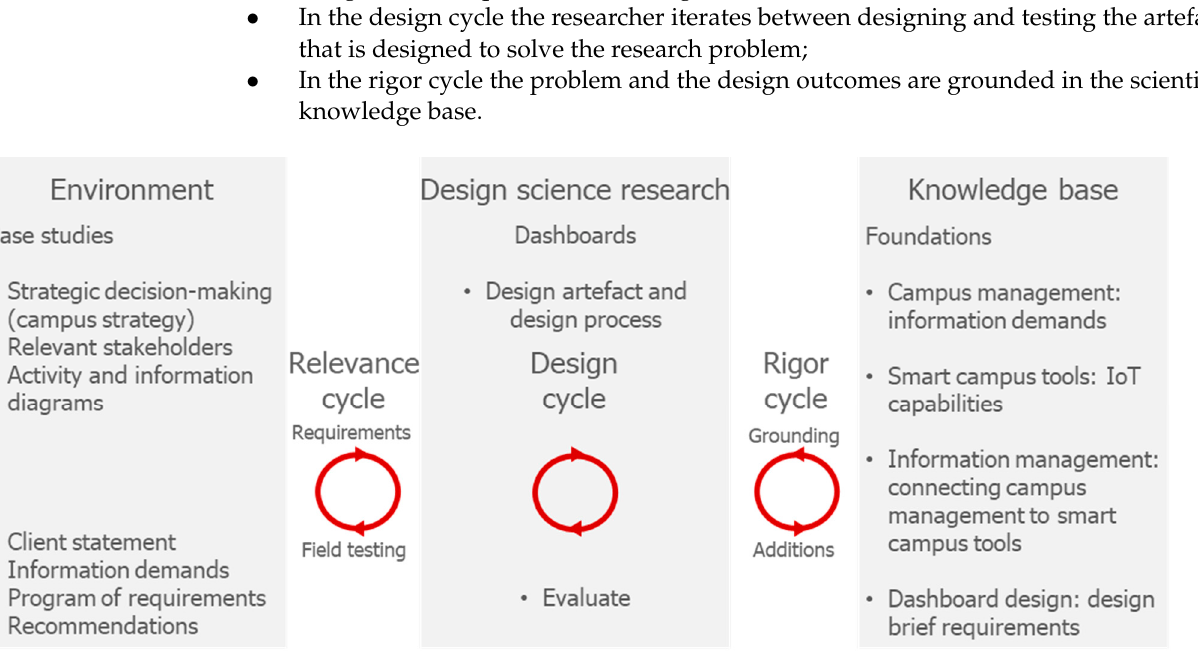
Figure 2. Design research cycles in this research (adapted from